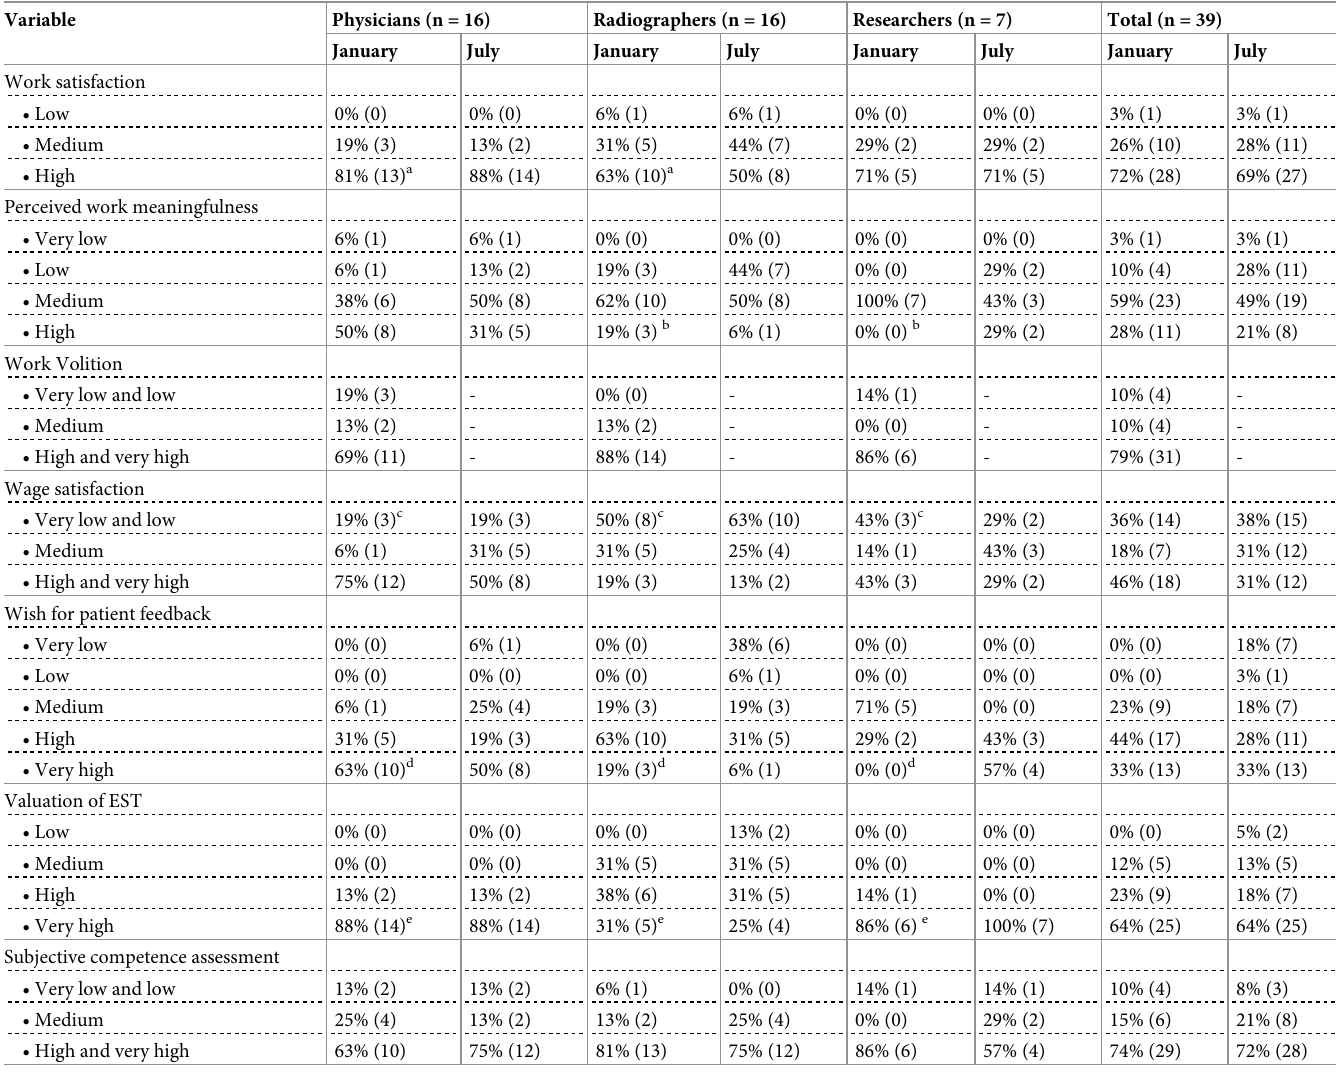
Table 1. Frequency of questionnaire variables in January and July 2020, separated by profession and in total, in % � (actual numbers reported in brackets).